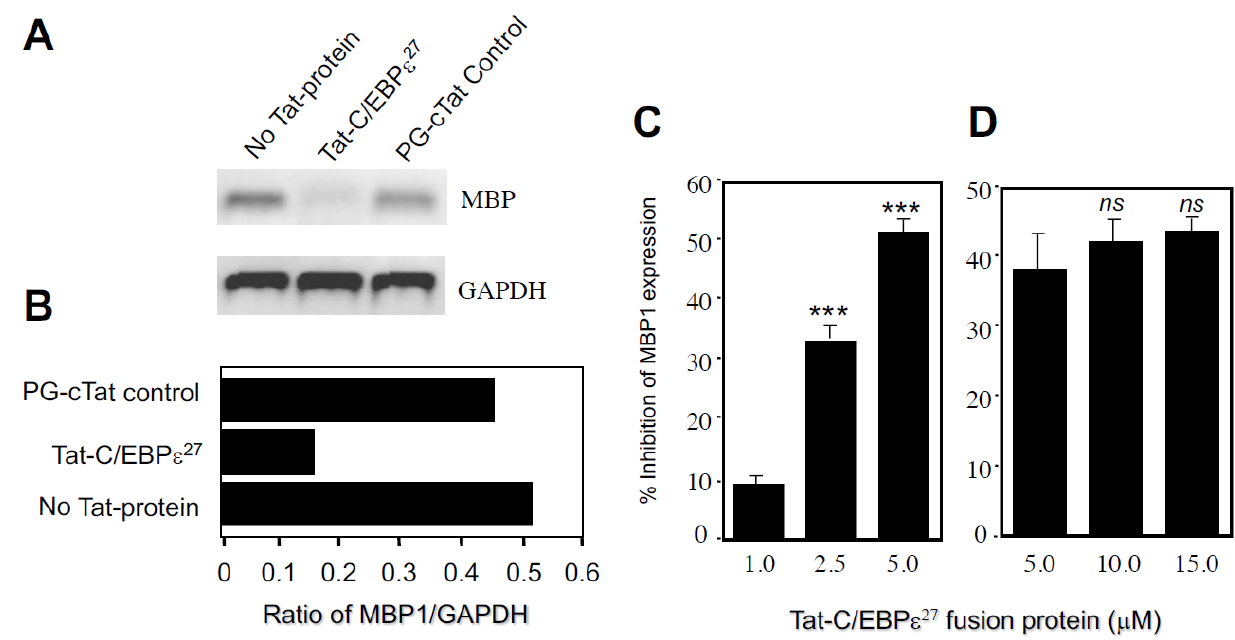
Figure 3. Transduction of AML14.3D10 eosinophils with a TAT-C/EBP ε 27 fusion protein induces dose-response inhibition of endogenous MBP1 gene expression. ( A , B ) AML14.3D10 eosinophil myelocytes (1 × 10 6 cells) were transduced with 80 μ g purified TAT-C/EBP ε 27 fusion protein (3.5 μ M), a PG-cTAT fusion protein control (8.6 μM ) or not transduced. Cells